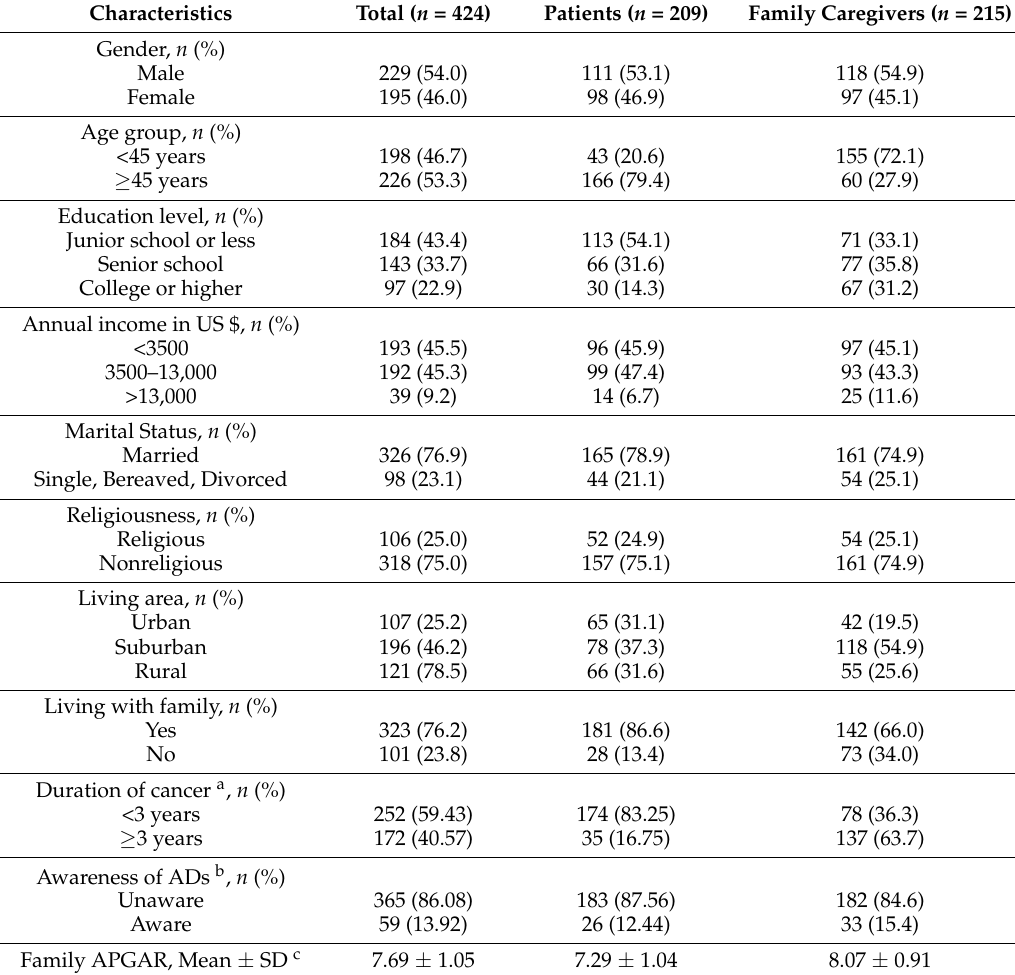
Table 1. Characteristics of the study